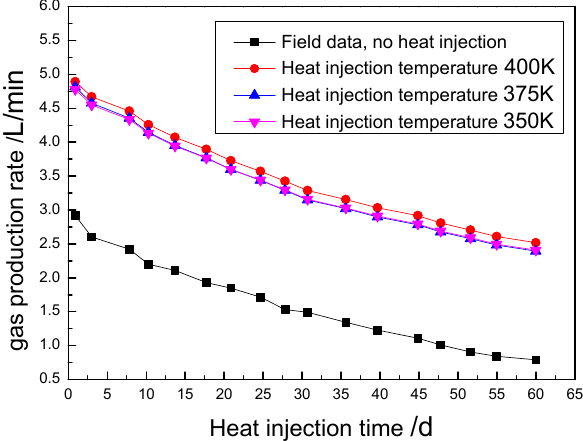
Figure 3. E ff ect of heat injection temperature on gas production Figure 3. Effect of heat injection temperature on gas production rate.